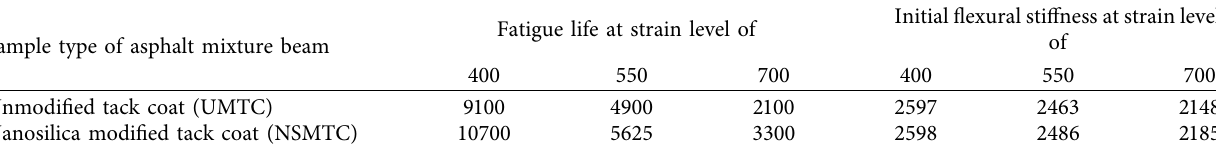
Sample type of asphalt mixture